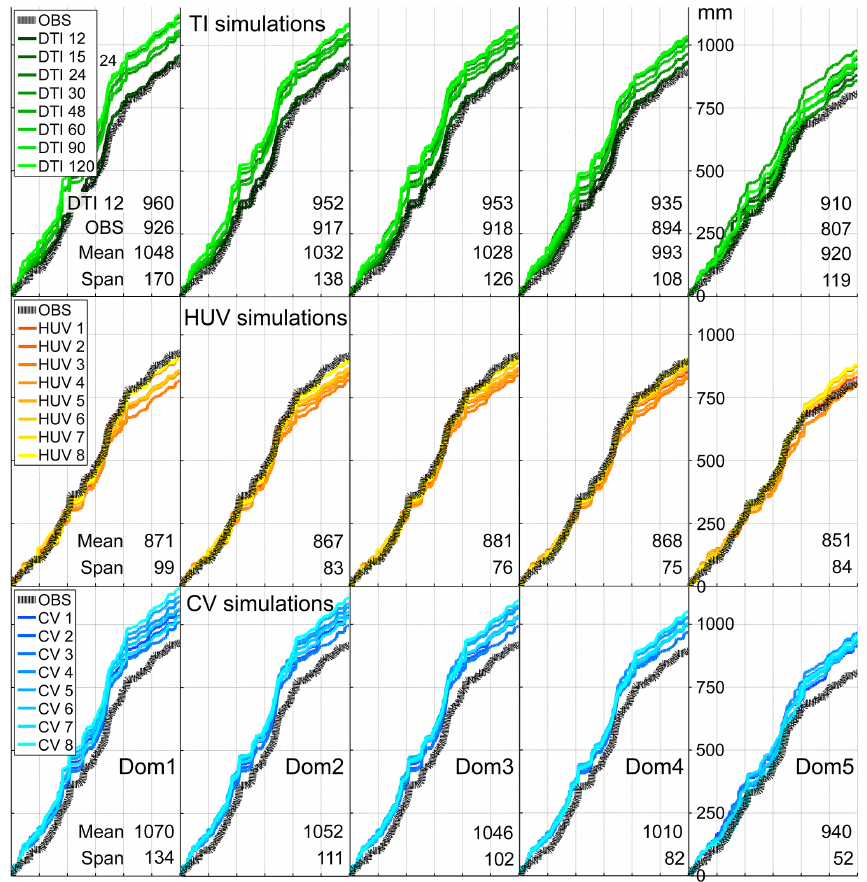
Figure 6. Precipitation sum curve for the evaluation period 1 May 2009 to 30 April 2010 for the five test domains and the TI, HUV and CV simulations as well as the observations. Also given are the simulated mean values, the span in the period sum for each plot group (minimum value subtracted from maximum value) and the observed mean